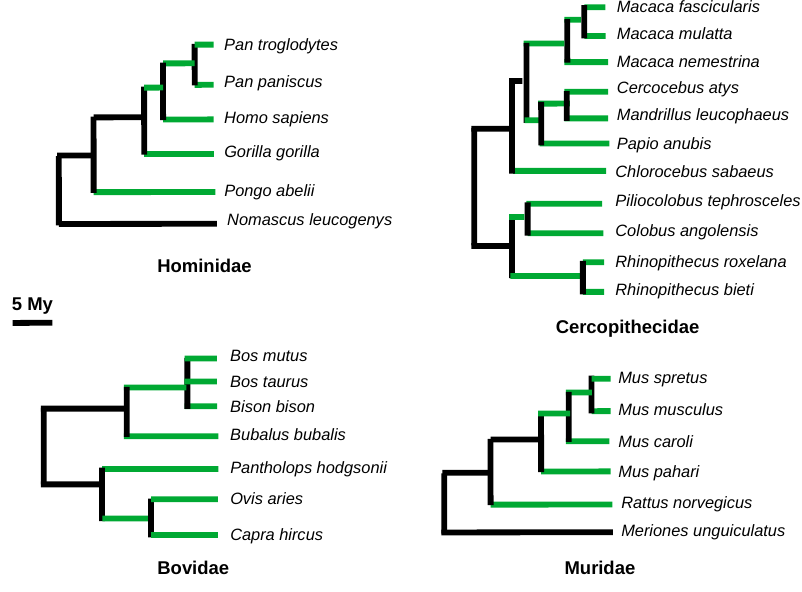
Figure 1 – The four families, 32 species and 40 lineages of mammals (green branches) analysed here. Branch lengths are proportional to the estimated divergence